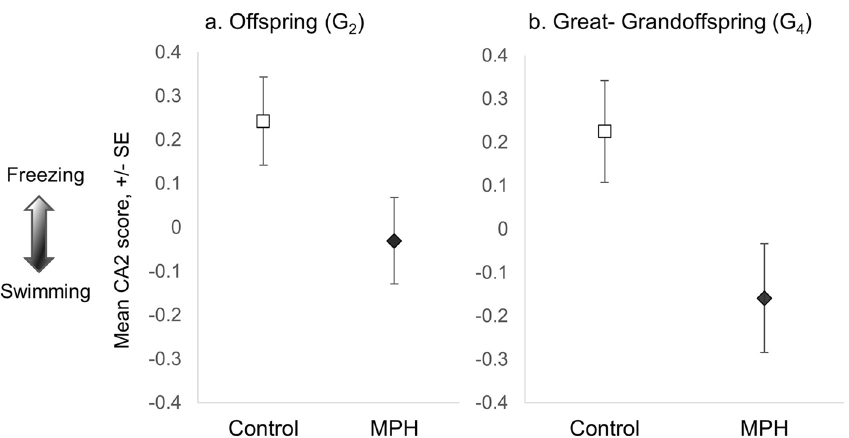
Figure 4. CA2 scores for offspring (G 2 ; panel a ) and great-grandoffspring (G 4 ; panel b ) in the open field test. Panel ( a ): Offspring of MPH treated sires spent significantly more time swimming in the open field tub than offspring of Control sires. Panel ( b ): Great-grandoffspring (G 4 ) descended from G 1 MPH treated males spent significantly more time swimming throughout the open field tub than great-grandoffspring descended from G 1 Control males. Positive CA2 values indicate relatively more freezing and negative values indicate relatively more swimming. Symbols represent least-square means for each response variable, + /− one standard